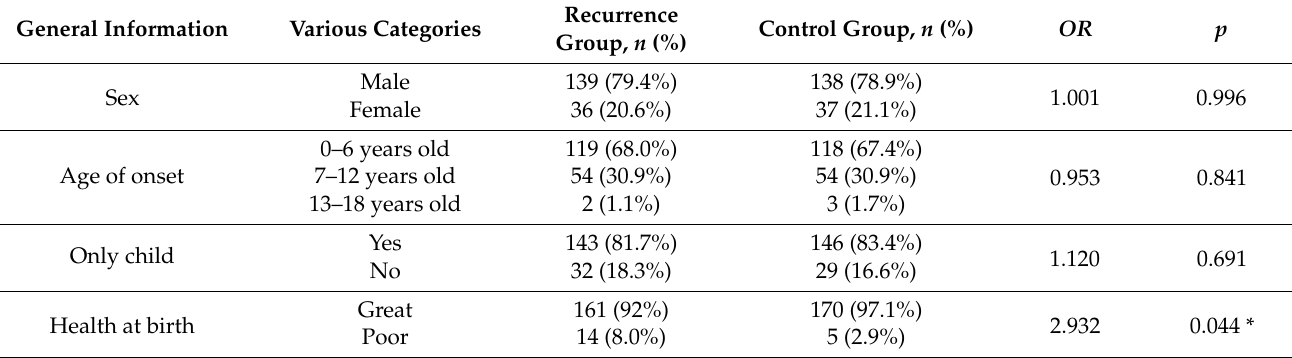
Table 1. Correlation between general information and tic recurrence (non-modifiable